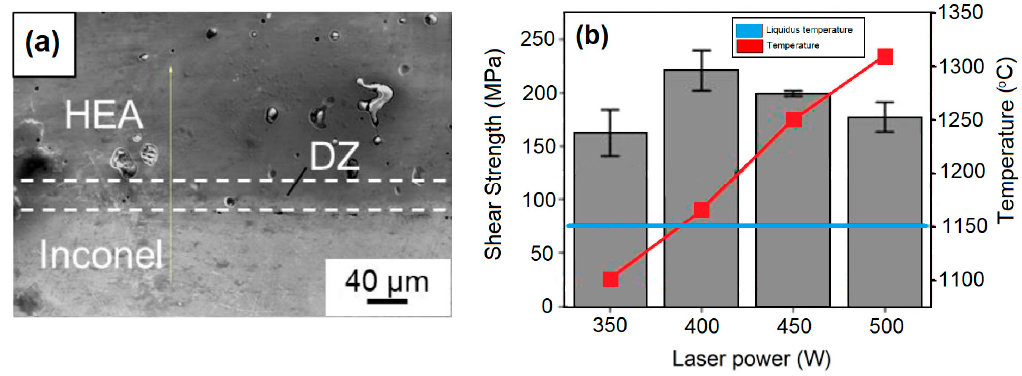
Figure 11. Brazing dissimilar welding between HEA and Inconel 718. ( a ) Metallurgical bond and ( b ) relationship between shear strength and brazing temperature. Adapted from [41].